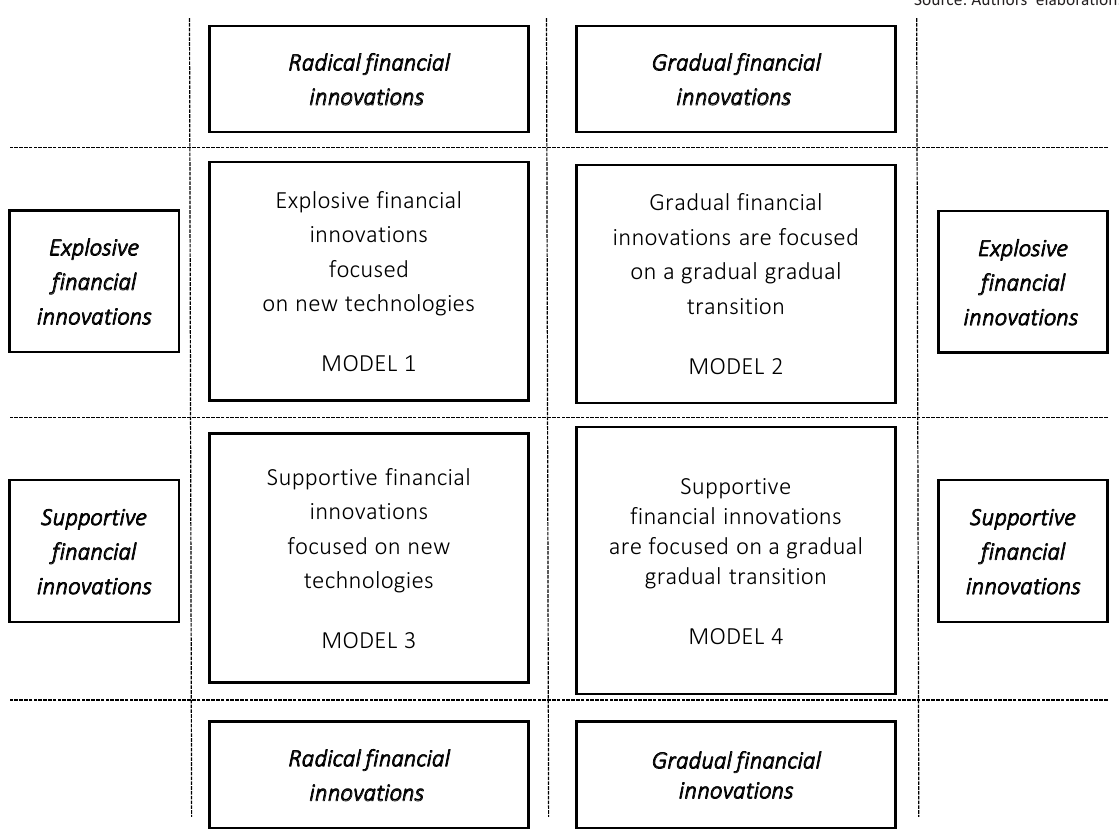
Figure 3. Matrix of financial